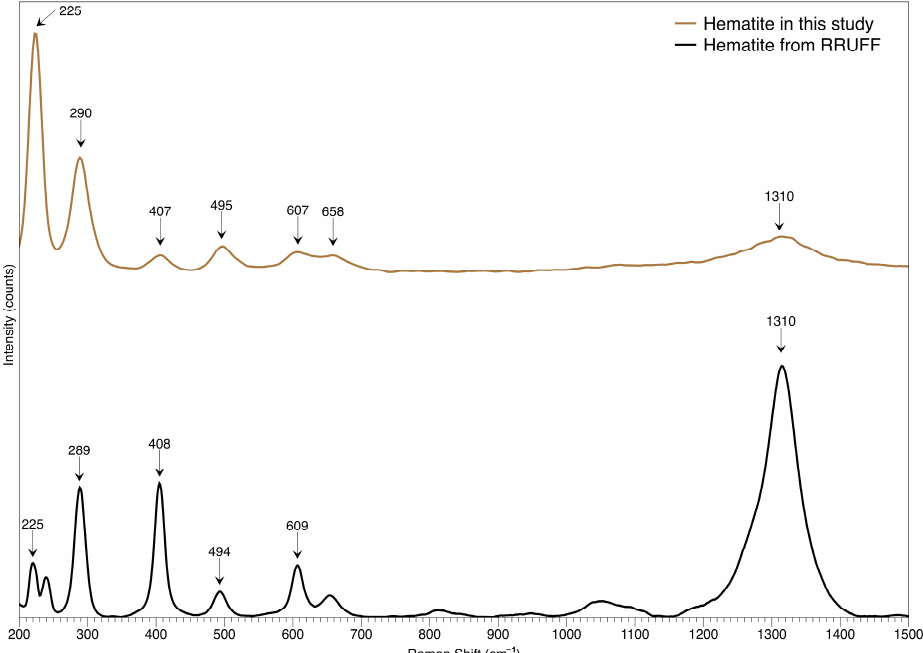
Figure 13. Raman spectrum analysis identifies the large and brownish-red platy inclusion as hematite, with two feature peaks at 225 and 290 cm − 1 and small peaks at 407, 495, 607, and 658 cm − 1 , and a prominent broad centered at 1310 cm − 1 , agreeing with the main peaks of hematite from the RRUFF online database.